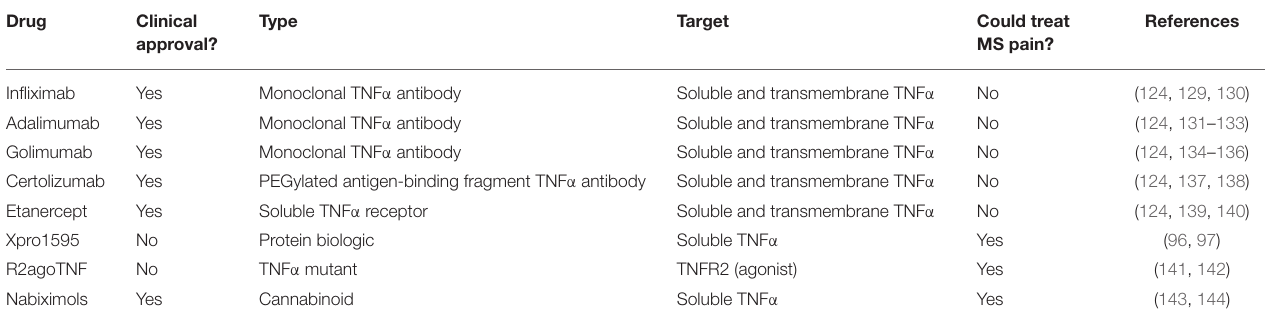
TABLE 2 | TNF α -targeted therapies.